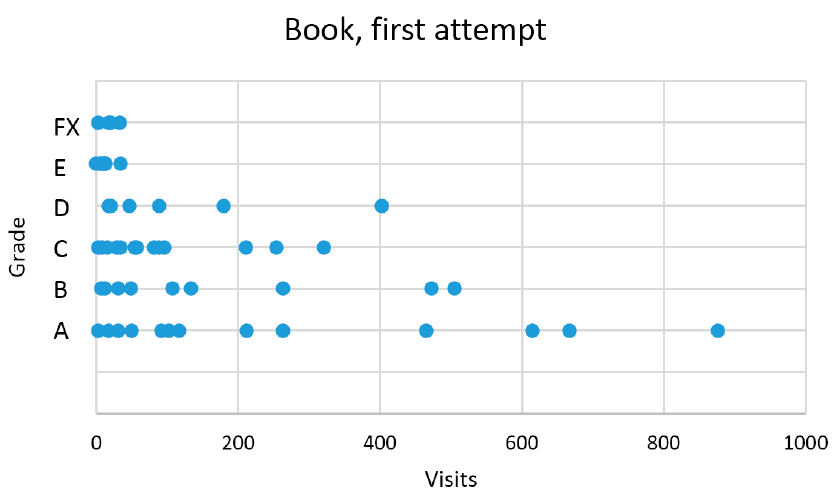
Figure 13. Grades based on visits in “Book”material, at the first attempt.